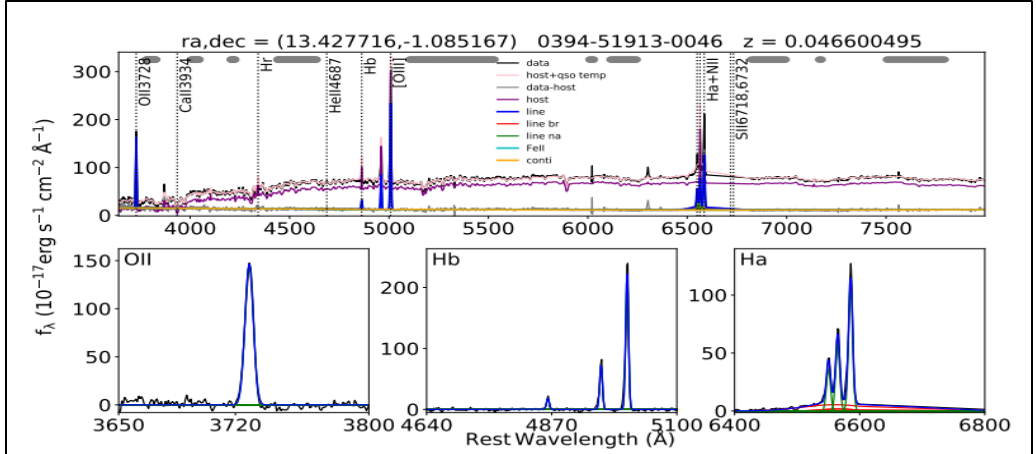
Fig.1: Spectral modeling for seyfert galaxies type1. The observed galaxy is shown in black line. The staller continuum is shown in faint brown line. The fitting component is in different colors. Fe present in teal II